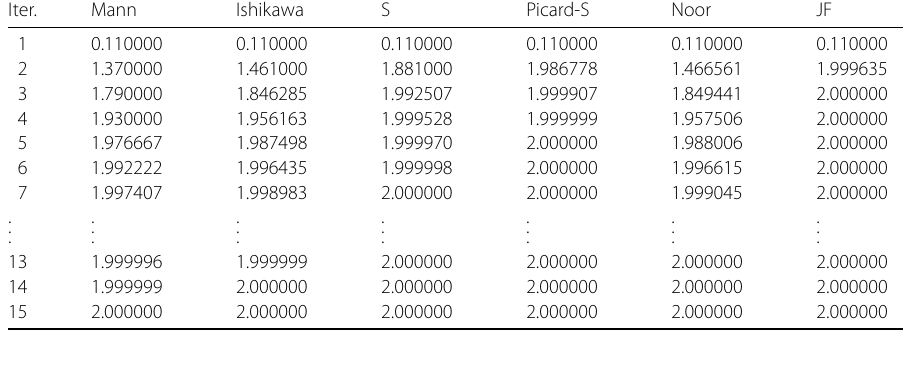
Table 3 Numerical comparison of iteration processes